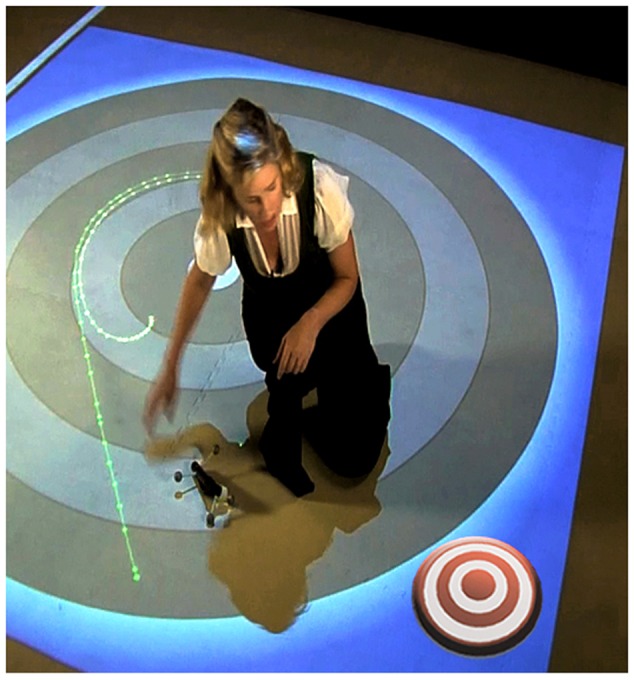
The Target Game. There are two “ghost trails” on the floor. The line that continues to curve represents the handheld component. The line that straightens represents the bob’s tangent at point of release.